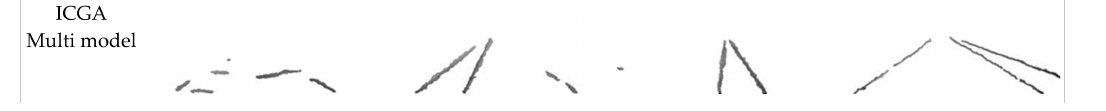
Figure 7. Comparison of results of segmentation and cracks detection for the Roadway cracks dataset.